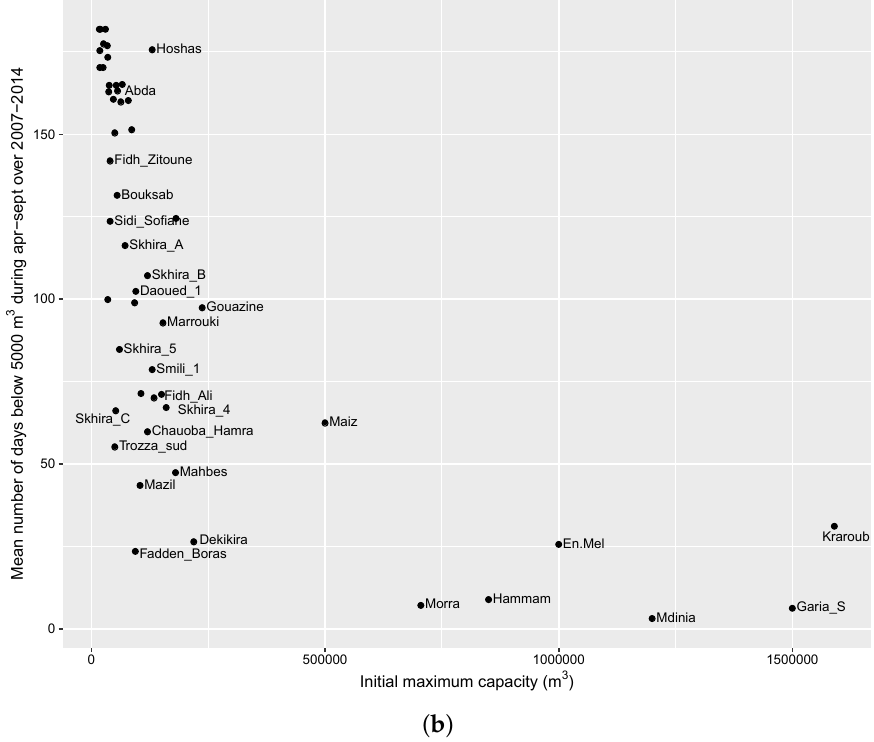
Figure 19. Relationship between the initial capacity of each lake and water availability parameters. ( a ) Correlation between initial maximum capacity of lakes and mean daily volumes over April–September; ( b ) correlation between the initial maximum capacity of lakes and the mean number of drought days/year (here, droughts refer to volumes <5000 m 3